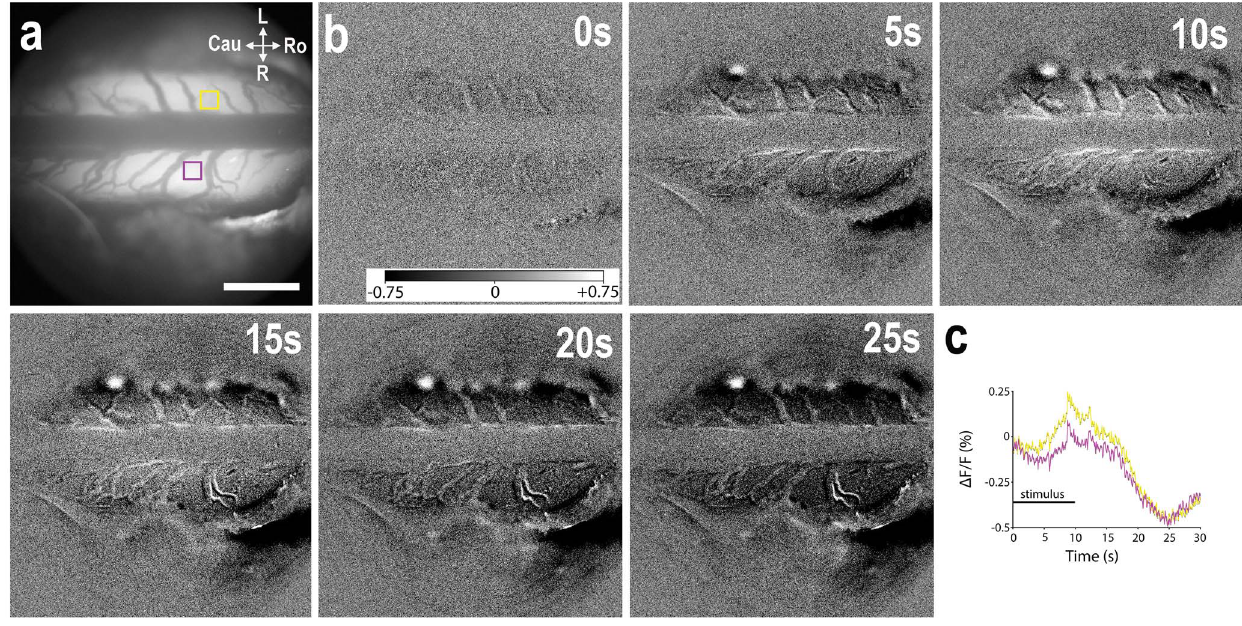
Figure 2. Spinal cord AFI signal following nociceptive electrical stimulation of the sciatic nerve, in a rat with partial ligation of the proximal sciatic nerve (Seltzer model). (A) Image of background fluorescence showing the dorsal surface of the spinal cord at the T13 vertebral level. The upper half is left, the lower half is right, the dark structure in the center is a dural vein. (B) Subtracted D F/F images at various time points after start of electrical stimulation (2.5 mA, 10 Hz) of the left sciatic nerve. (C) Graph showing the time course of D F/F in the yellow (left, i.e. ipsilateral or stimulated side) and purple (right, i.e. contralateral side) 20 6 20 pixel square selections in (A). Scale bar, 1 mm. Gray scale bar ranging from 2 0.75% (black) to + 0.75% (white) of the 16-bit range; Cau = caudal, Ro = rostral, L = left, R = right.